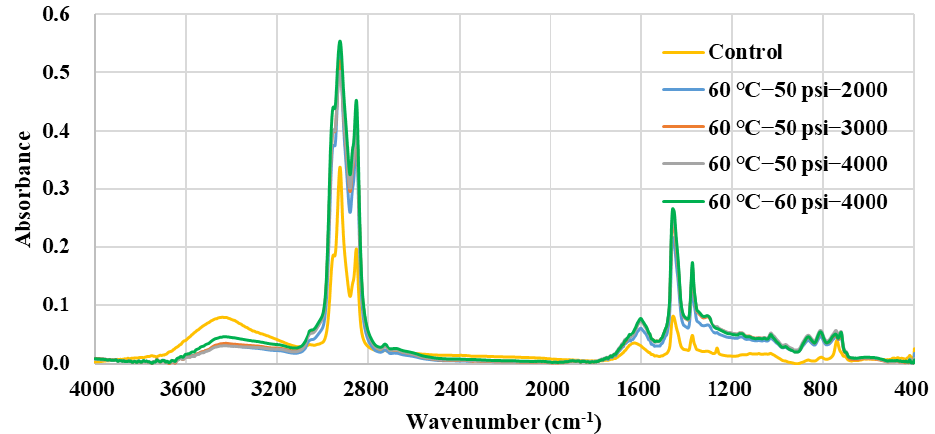
Figure 14. FTIR spectra of different types of asphalt binder.